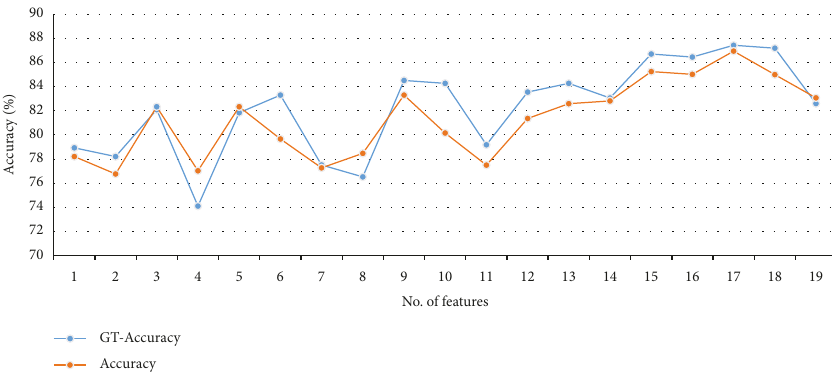
Figure 3: Classification accuracy recorded for GT data and forecasted data.